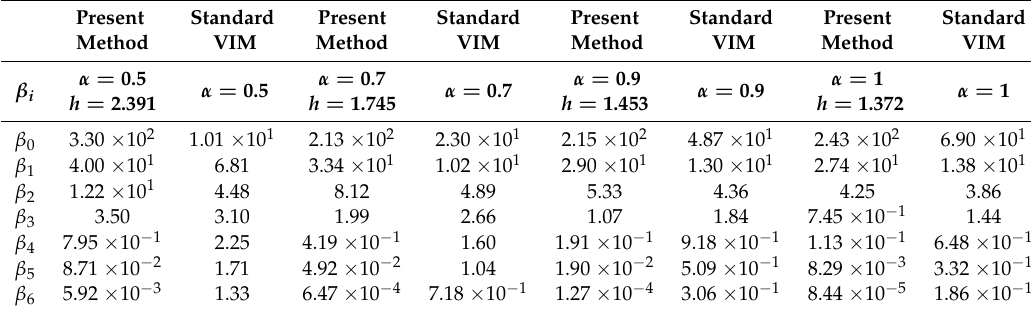
Table 4. Values of β i defended in (16) for present method and standard VIM with N = 7 in Example 1.